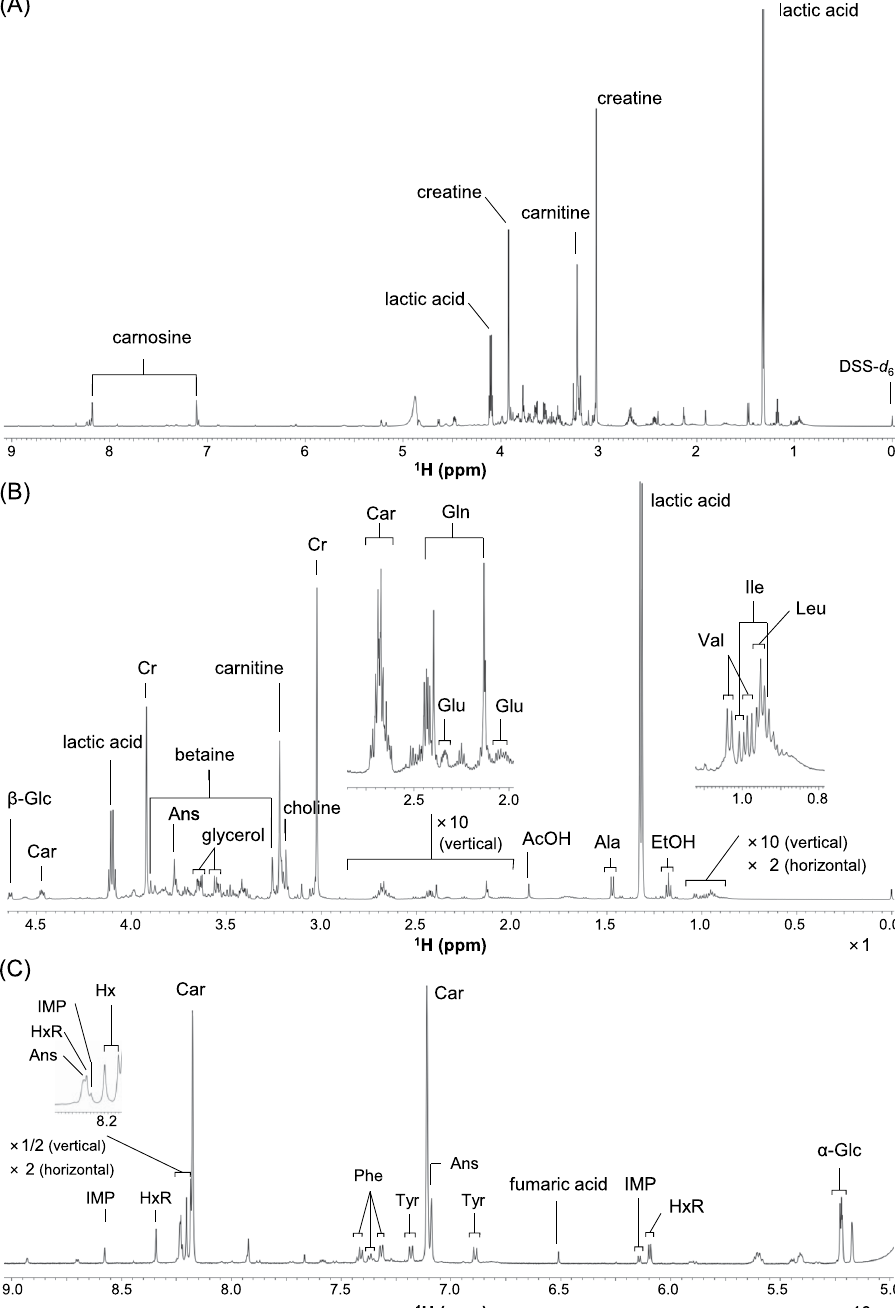
Figure 1. 1 H NMR spectra of the D 2 O extract of a sirloin sample from a brand A Black heifer (2-week aging). Assigned signals are labeled in ( A ) full spectrum, ( B ) high-field region, and ( C ) low-field region. AcOH, acetic acid; Ala, alanine; Ans, anserine; Car, carnosine; Cr, creatine; EtOH, ethanol; α -Glc, α -D-glucose; β -Glc, β -D-glucose; Gln, glutamine; Glu, glutamic acid; Hx, hypoxanthine; HxR, inosine; Ile, isoleucine; IMP, inosine monophosphate; Leu, leucine; Phe, phenylalanine; Tyr, tyrosine; and Val,